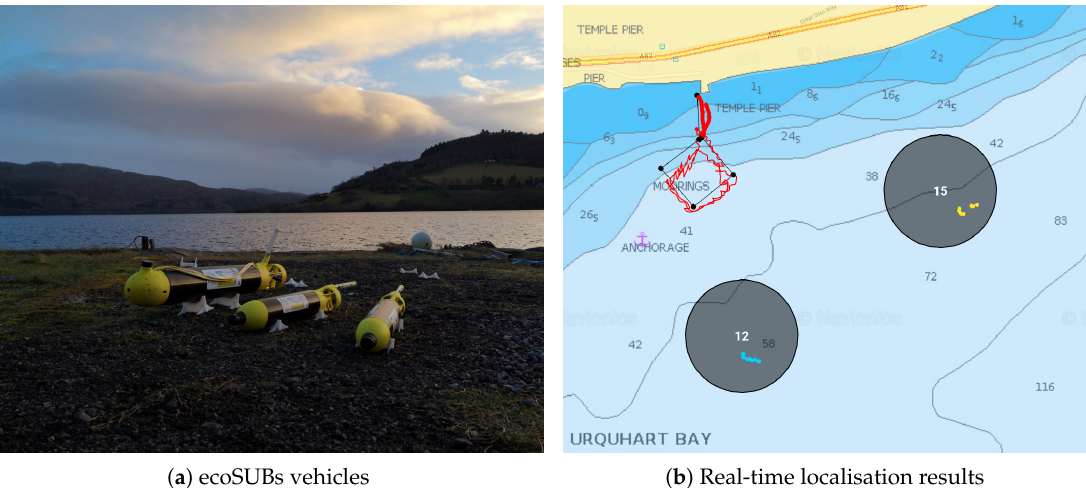
Figure 9. Experimental deployment of the system envisioned in the LCAT project in Loch Ness, UK, on 29 January